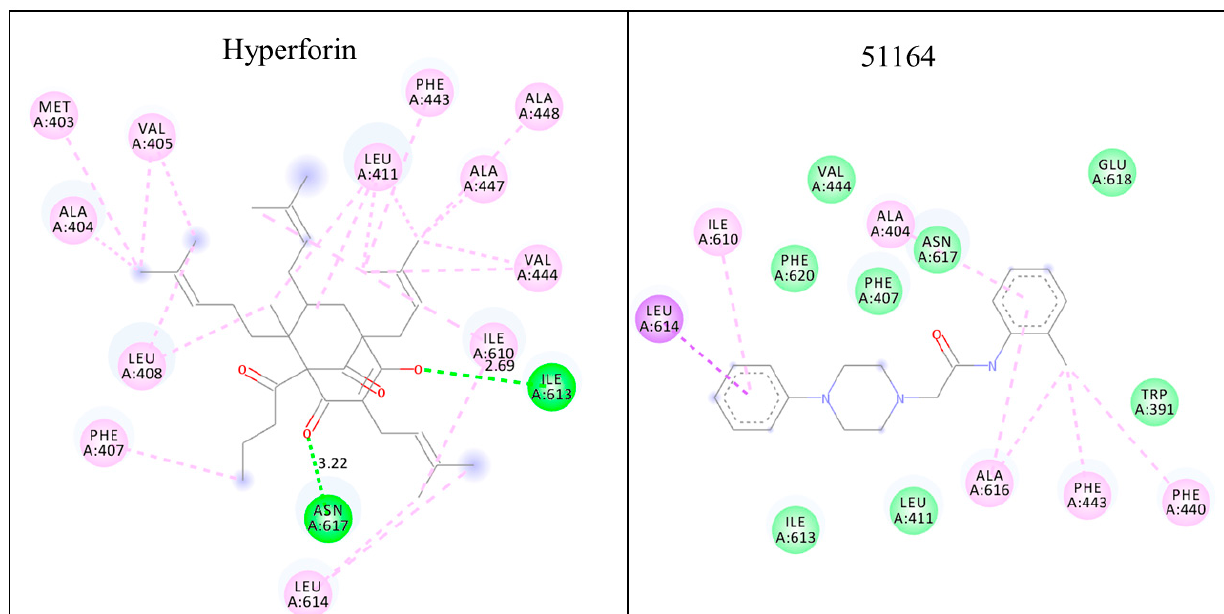
Figure 1. Conformation map of complexation of hyperforin and 51164 with TRPC6. For hyperforin, two hydrogen bonds are visualized with ASN617 (A: ASN617:N2—:Hyp:O) and ILE613 (Hyp:O—A:ILE613:N) with distances of 3.22 Å and 2.69 Å with 64.4° and 45.8° angles, respectively (dark green). All other residues exhibit a hydrophobic type of interaction (purple, alkyl type of bounding). PHE443 exhibits Pi-alkyl type of bounding. For 51164, we find mostly the hydrophobic type of interaction. LEU614 interacts with the Pi-Sigma type to the side aromatic ring of 51164 (A:LEU614:CA— 1C6:51164) with an angle deviation of 12.82° and Theta of 8.355 (dark purple). For ALA616, we observed an alkyl type of interaction (3C6:51164: Cl—A:ALA616). PHE443, PHE440, ALA404, and ILE610 hydrophobic residues interacted with the Pi-Alkyl type by maximal 5.45 Å distance. ILE613; LEU411; PHE620; PHE407; ASN617; GLU618 and TRP391 display the van der Waals interaction type (light green).